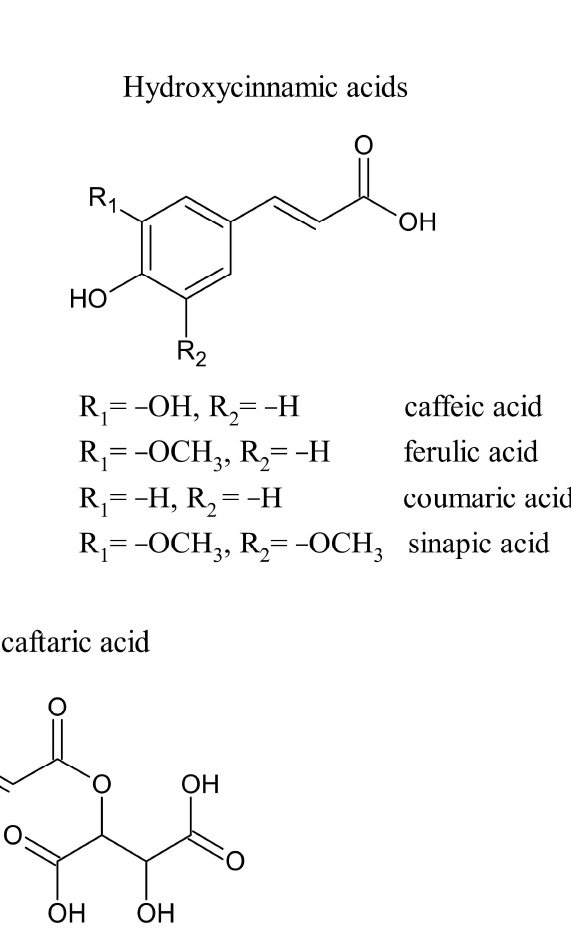
Figure 1. Chemical structures of hydroxybenzoic and hydroxycinnamic acids and of caftaric acid .